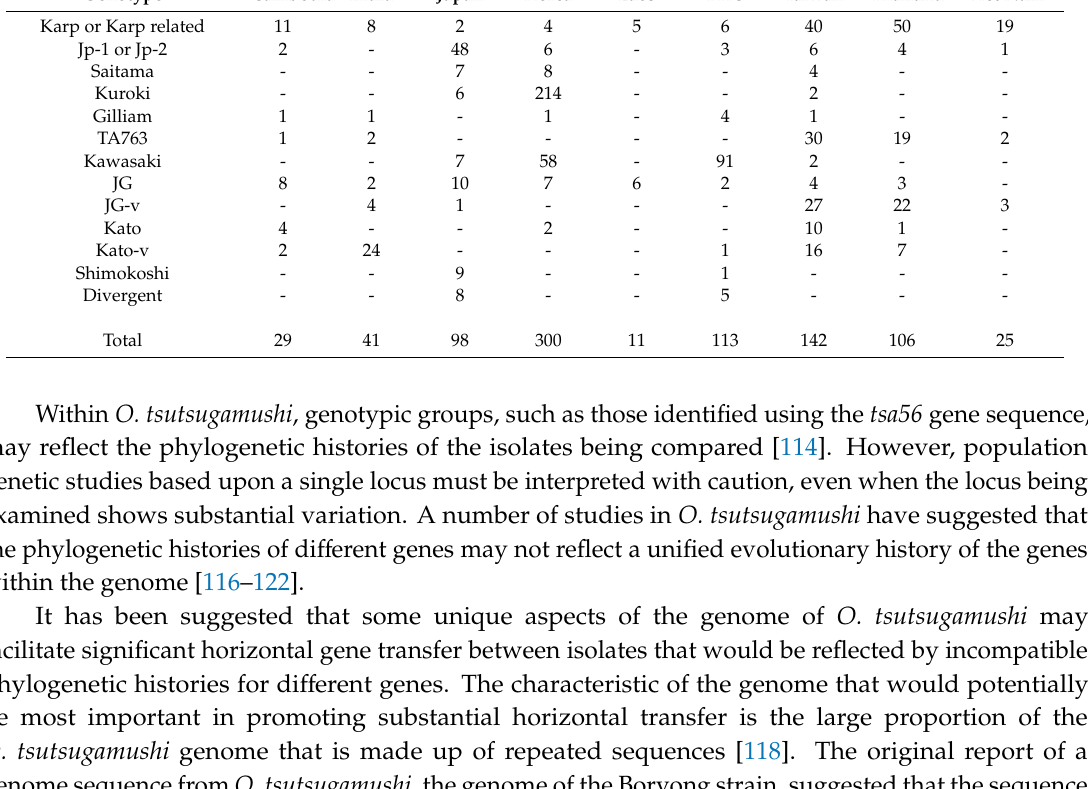
Table 1. Distribution among various locations of the tsa56 gene sequences of O. tsutsugamushi deposited in the DNA databases, as placed into genotypic classes defined by Kelly et al. (2009) [111].